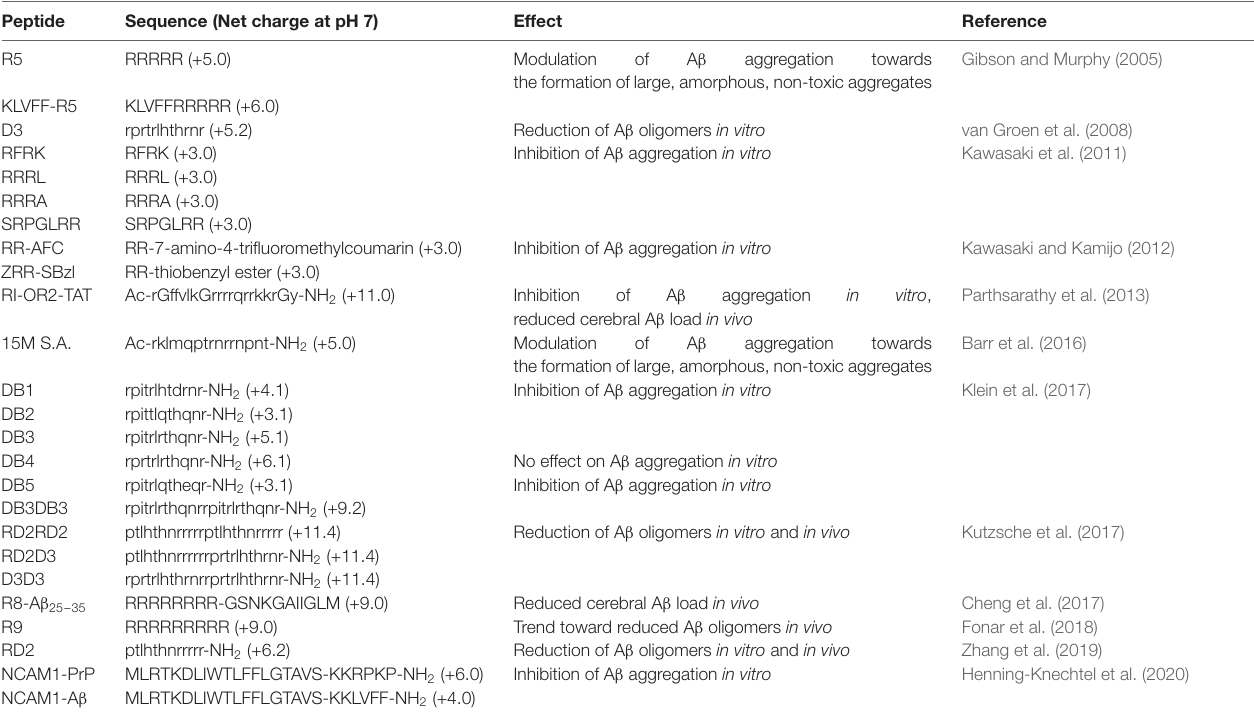
TABLE 1 | Cationic arginine-rich peptides with modulatory effects on amyloid-beta aggregation. Peptide Sequence (Net charge at pH